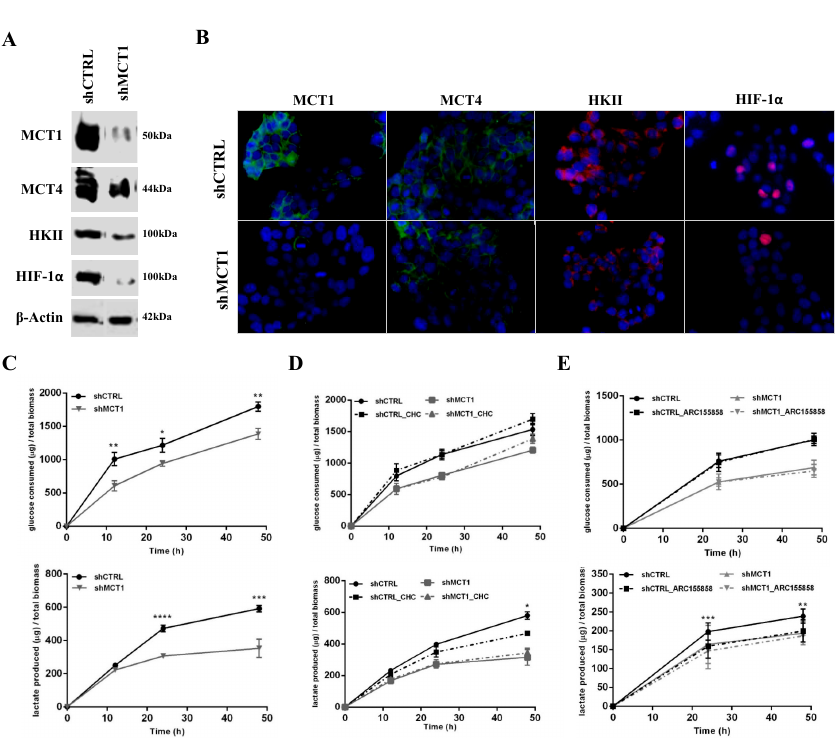
Figure 2. Effect of MCT1 downregulation on cell metabolism. Expression of MCT1, MCT4, HKII and HIF-1 α in U251